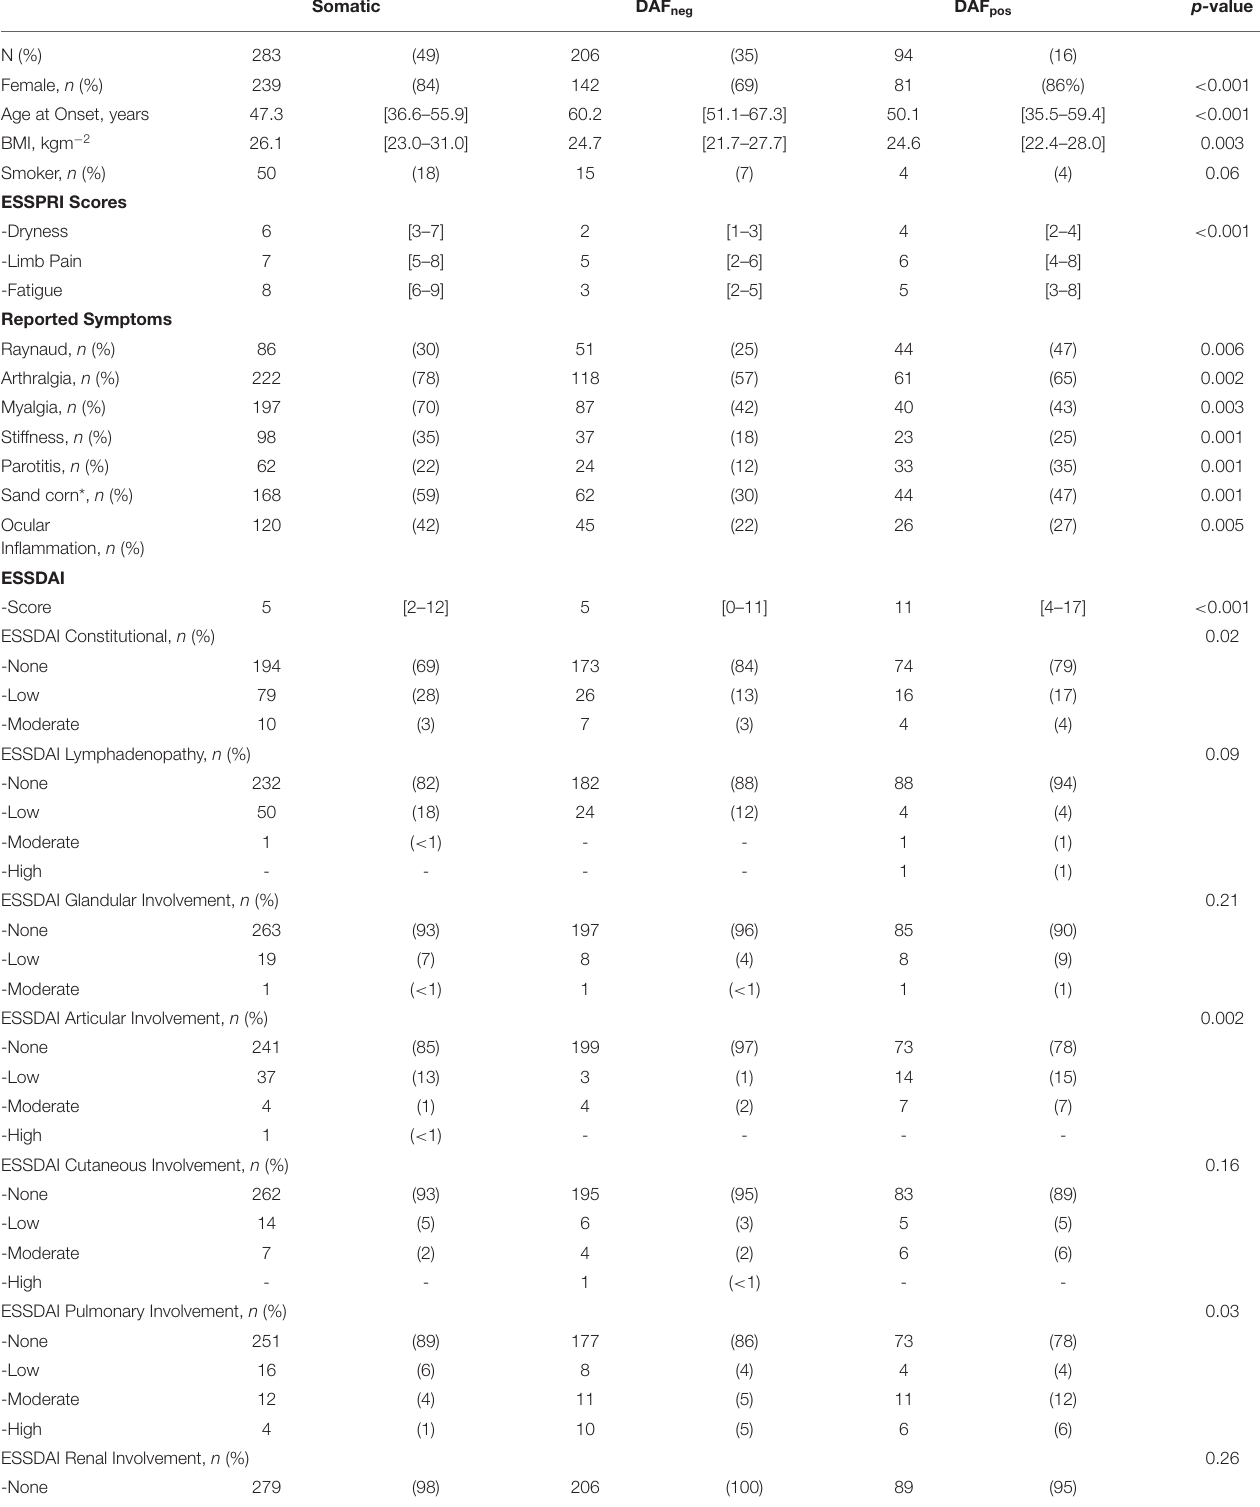
TABLE 1 | Comparing and contrasting the clinical demographics and attributes of the entire cohort subdivided into the three groups identified through principal component analysis and subsequent hierarchical clustering. Somatic DAF neg DAF